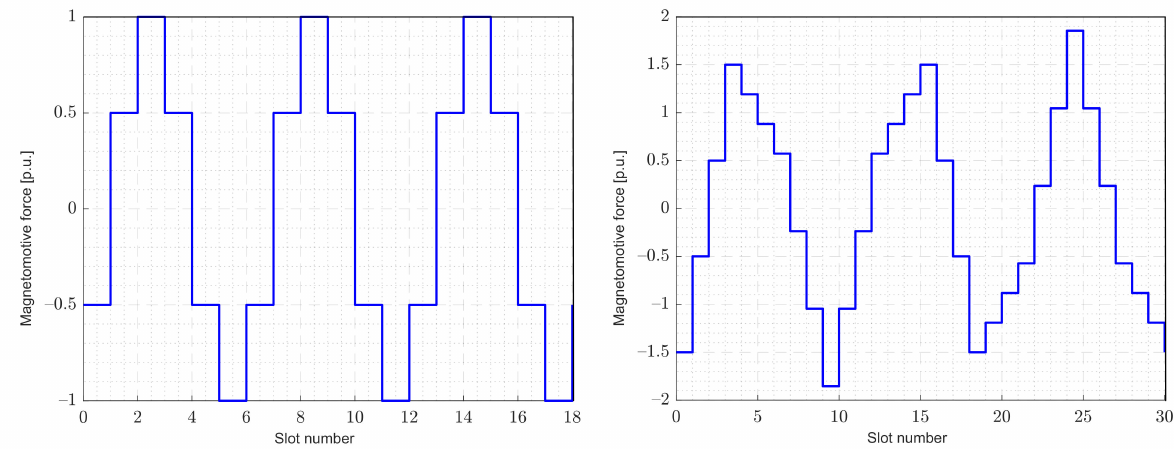
Figure 5. Magnetomotive force step-curve produced by injection of the third harmonic time component into the nine-phase winding with q = 1 and into the five-phase winding with q =